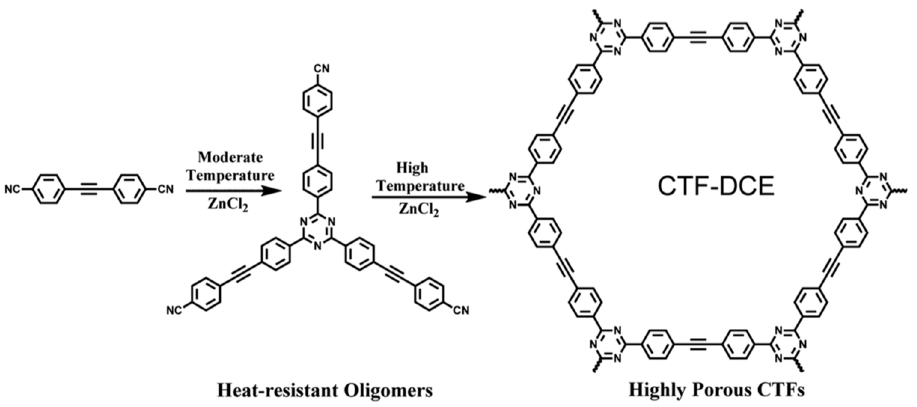
Scheme 4. Schematic representation of the coordination and stabilization of Ru NPs onto CTF material (Reproduced with permission from [34]. Copyright 2015,